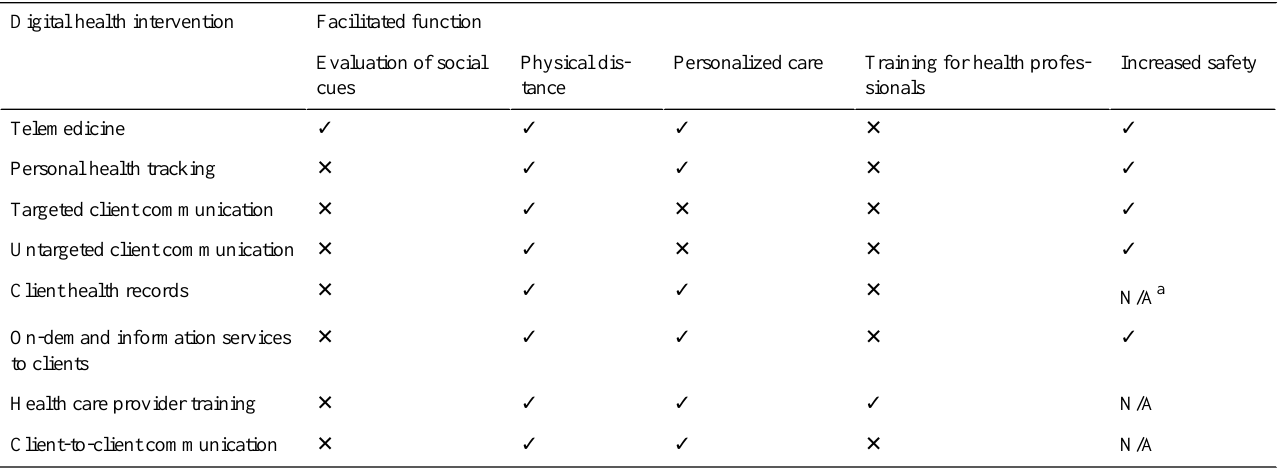
Table 6. Comparison of facilitated function and associated digital health